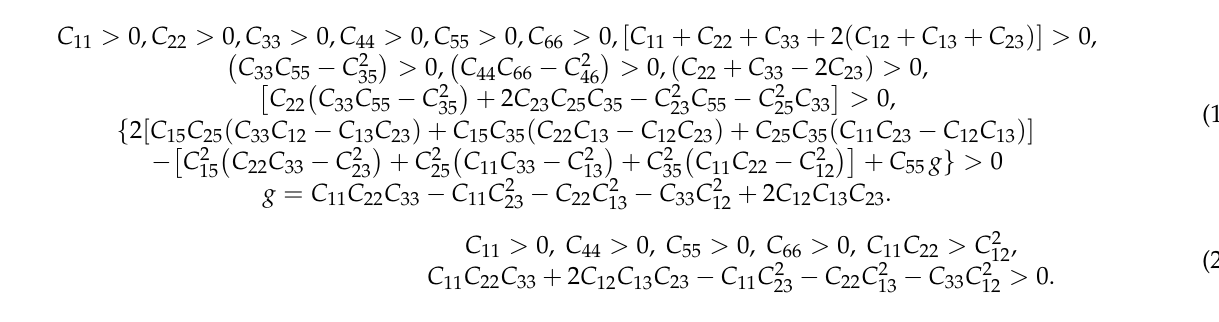
Table 2. The C ij of η (cid:48) -Cu 6 Sn 5 and Cu 3 Sn (GPa).